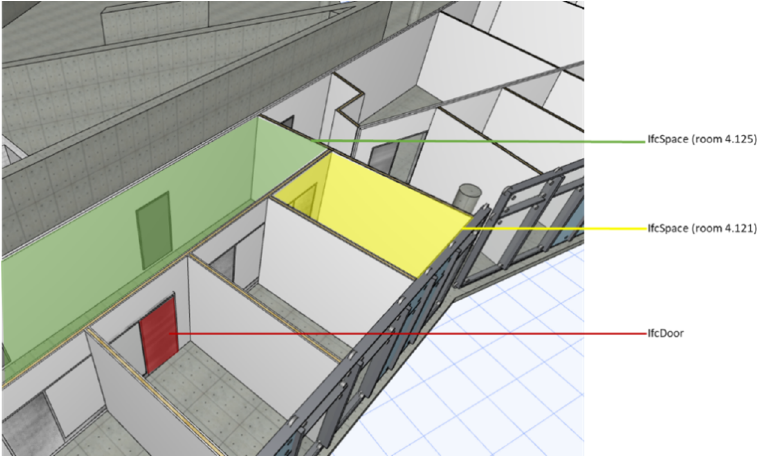
Figure 7. Extract of the prototype environment showing the objects IfcSpace and IfcDoor.